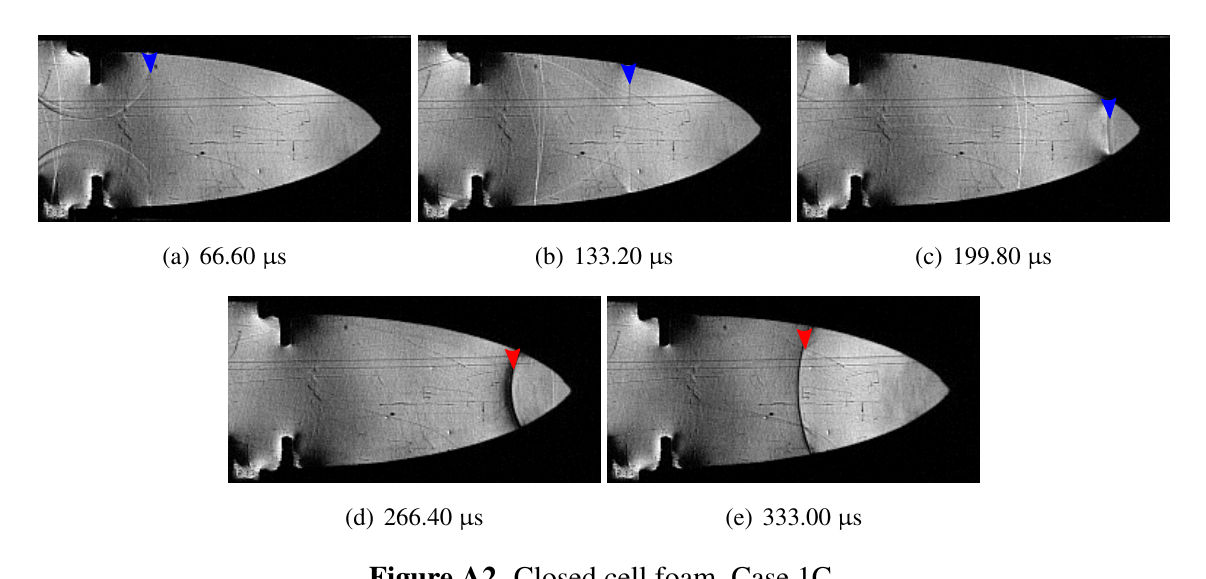
Figure A2. Closed cell foam, Case